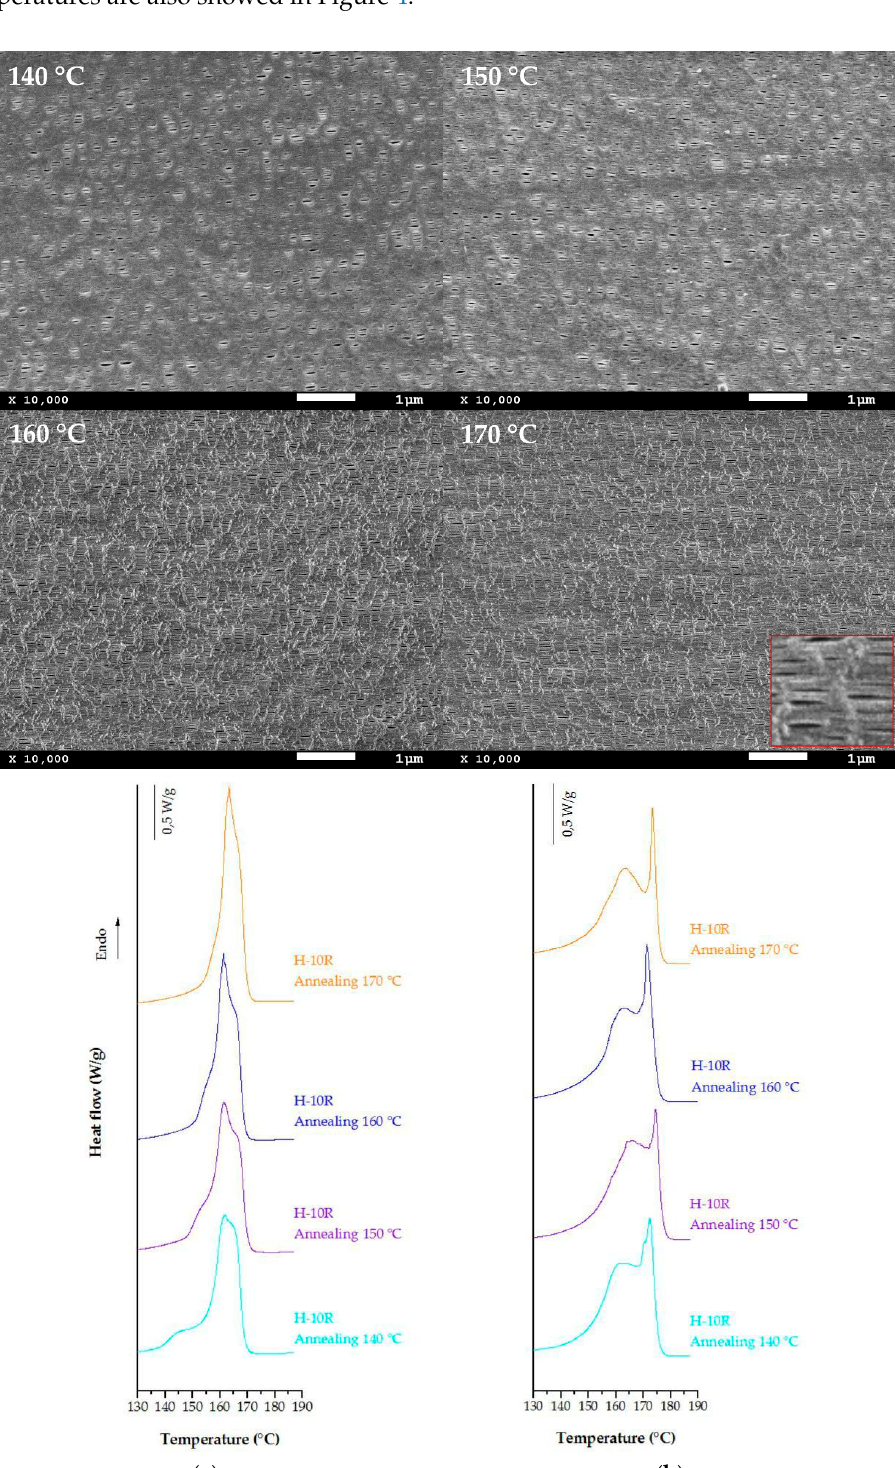
Figure 4. SEM micrographs and DSC thermograms of sample H-10R annealed at different temperatures ( a ) annealed precursor films, and ( b ) membranes (second stretching step at 140 ◦